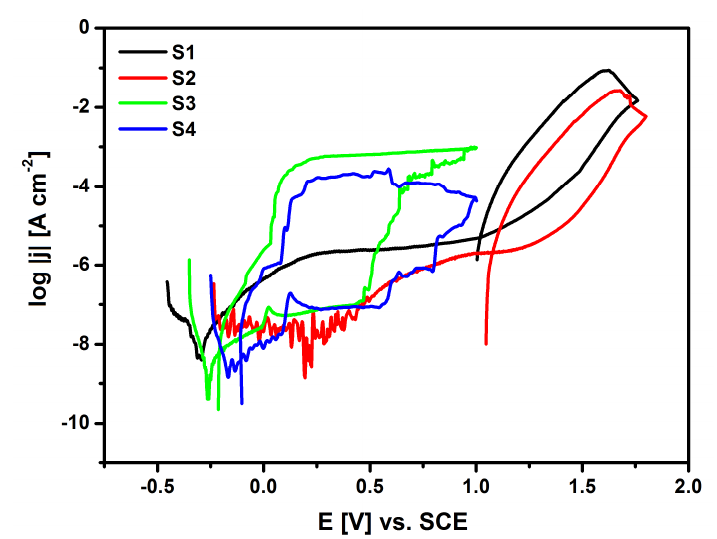
Figure 13. Anodic potentiodynamic curves j = f(E) on a semi-logarithmic scale for the NiTi alloy before and after surface modification in Ringer’s solution at 37 ◦ C, where: S1—NiTi alloy after mechanical polishing, S2—NiTi alloy after passivation in a steam autoclave, S3—NiTi alloy after sterilization with a sintered HAp / nSiO 2 / Ag coating (10:1, 40 V / 90 s), and S4—NiTi alloy after sterilization with a sintered HAp / nSiO 2 / Ag coating (5:1, 50 V / 120